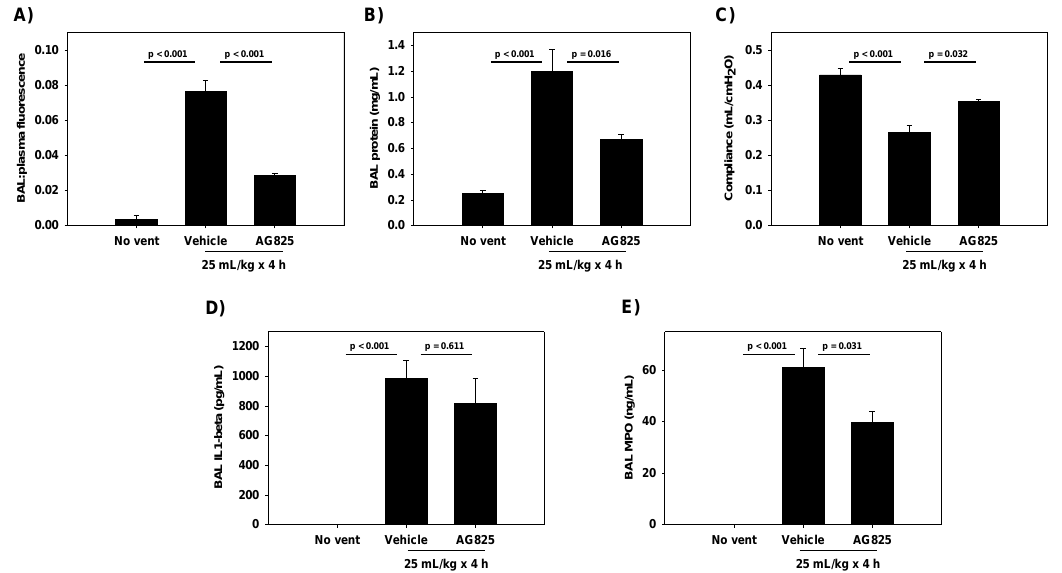
Figure 5. Effect of pre-treatment with AG825 (1.67 mg/kg IP × 3 days) on ( A ) lung permeability as measured by bronchoalveolar lavage (BAL): plasma fluorescence, ( B ) BAL protein concentration, ( C ) respiratory system compliance, ( D ) BAL Interleukin- 1β, and ( E ) BAL myeloperoxidase levels in rats subject to injurious ventilation for 4 h (V T 25 mL/kg, end-expiratory pressure 0 cmH 2 O, rate 27 breaths/min, FIO 2 0.21). AG825 improved permeability and compliance in this ventilator-induced lung injury (VILI) model, relative to vehicle (DMSO). n = 4; p values represent the result of ANOVA and post-hoc